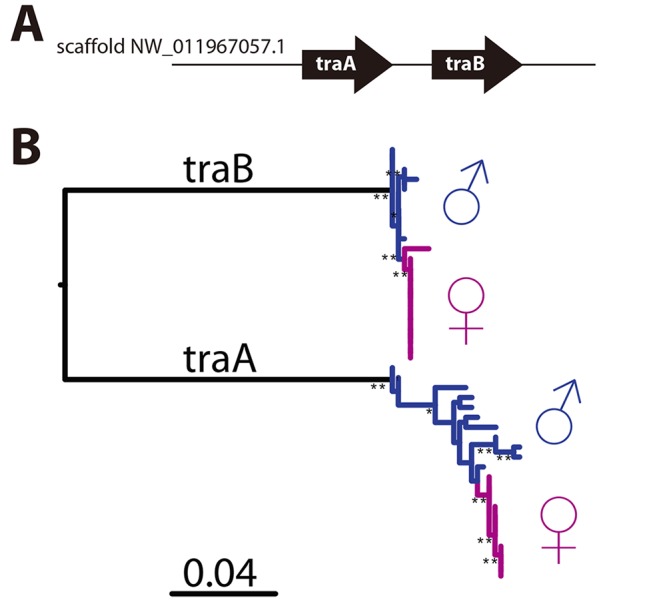

CsdQTL1 contains csd/fem with separate alleles in males and queen clones.(A) Locus CsdQTL1 contained two tandem copies of tra homologs on the same scaffold. (B) Males and queens have different copies of both traA and traB, but the former gene is more diverse. Nodes with 100% bootstrap support are shown with double asterisks and nodes with 90–99% support with single astersks. These data suggest that the traA and and traB copies diverged before male and female clones separated from each other. As a result, each mating produces workers heterozygous at this locus, which was also consistent with linkage mapping and diploid male production data. The traA gene has higher diversity than traB and weak evidence of diversifying selection (S3 Fig), suggesting by analogy with honey bees, that this is the homolog of csd, while traB is the homolog of fem. Scale bar is in substitutions per site.